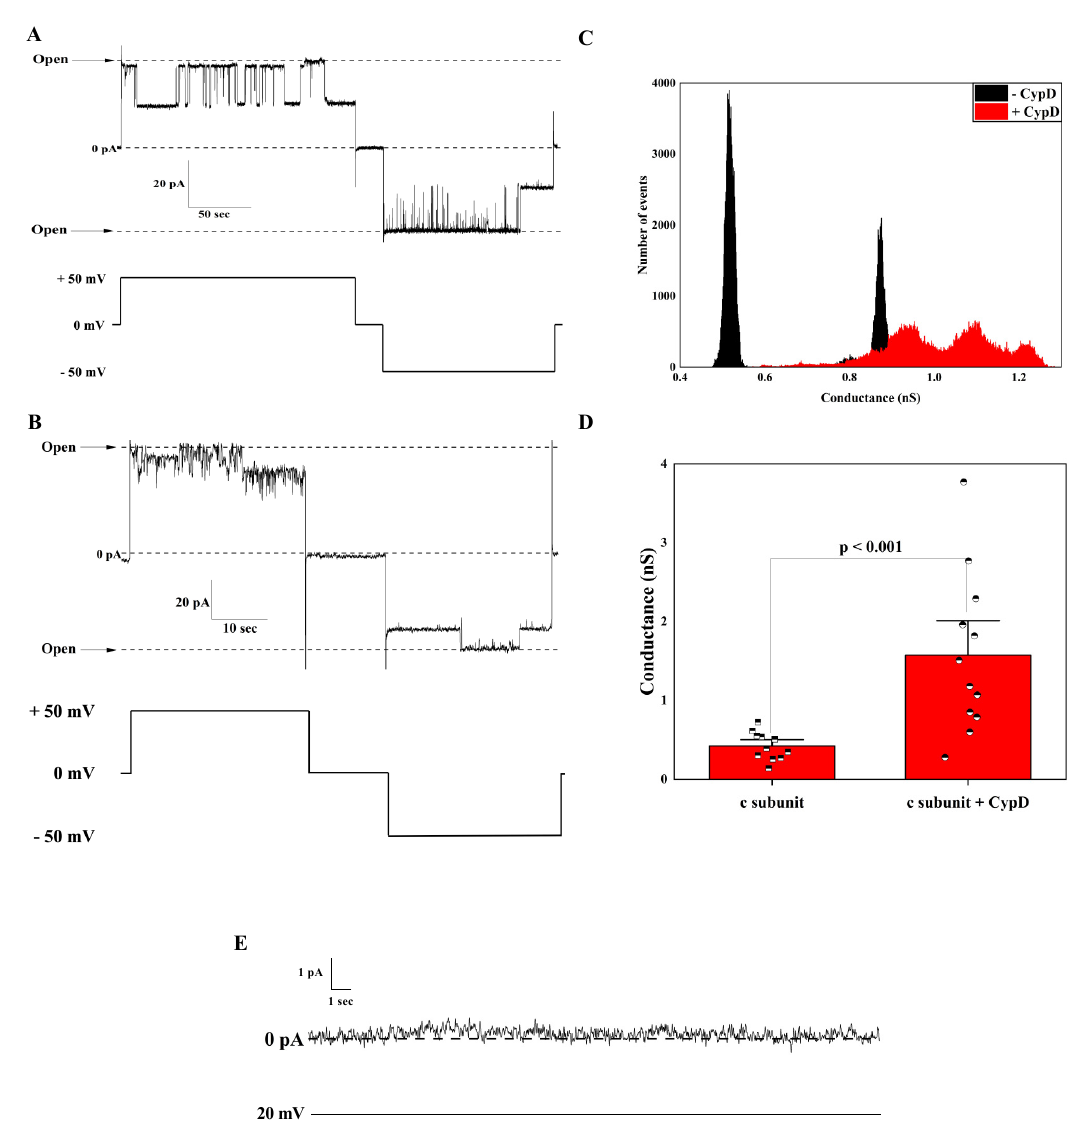
Figure 1. Modulation of the c subunit ion channel activity upon interaction with CypD. ( A ) Representative current trace of oligomers showing typical channel behavior with frequent transitions between fully open and lower conductance states; ( B ) Representative current trace of c subunit oligomers preincubated with CypD; ( C ) All points histogram corresponding to the traces shown in panel A and B; ( D ) Channel open state conductance values of the c subunit oligomers alone ( n = 11) and in presence of CypD ( n = 12); ( E ) Control trace of the bilayer prior to the channel insertion.